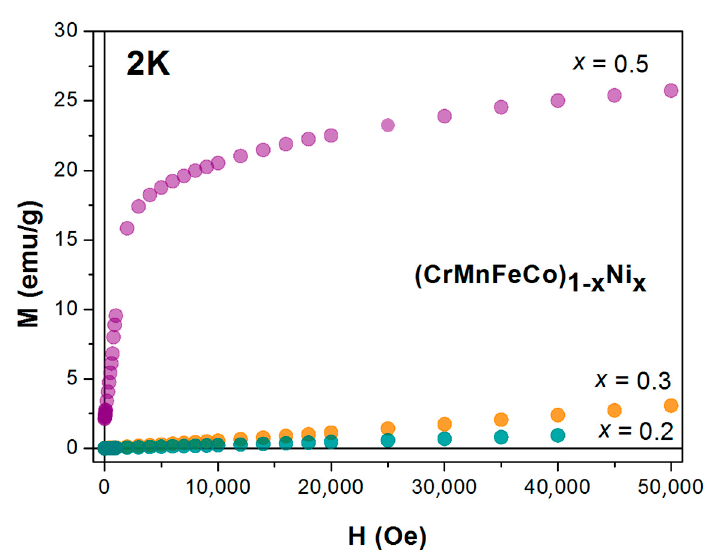
Figure 15. Magnetization isotherms of (TiZrNbCu) 1-x Ni x MGs with the lowest Ni content measured at a temperature of 2 K.